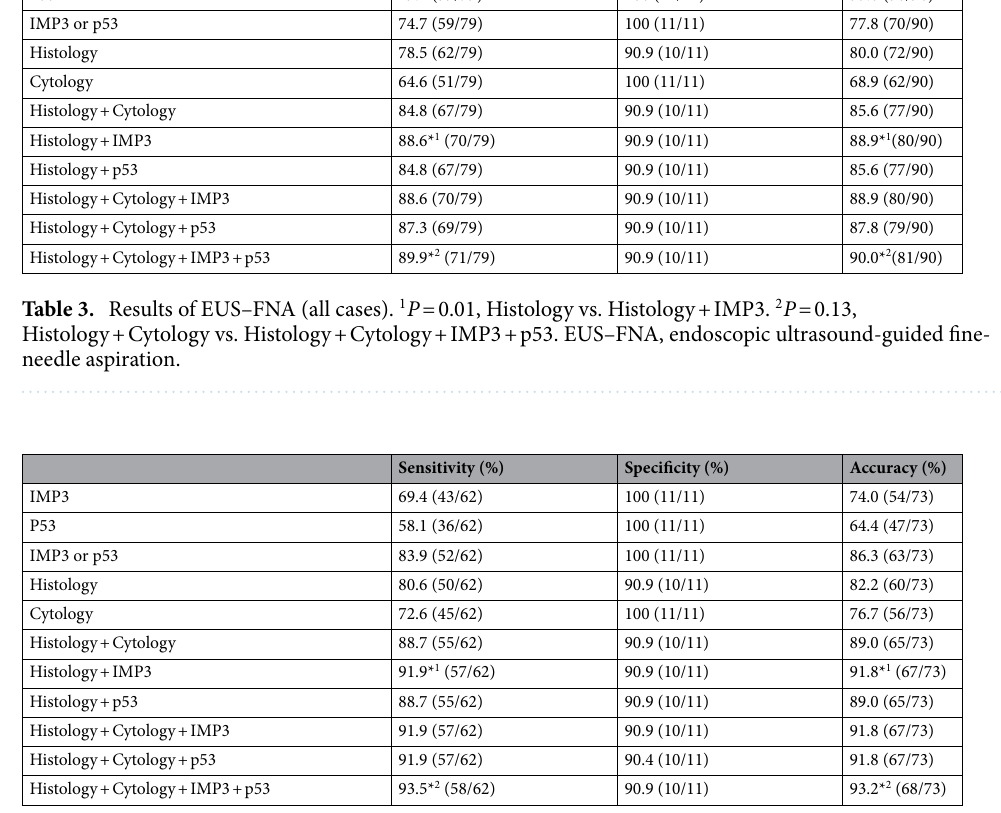
Table 4. Results of EUS–FNA (PDAC and benign diseases). 1 P = 0.02, Histology vs. Histology + IMP3. 2 P = 0.25, Histology + Cytology vs. Histology + Cytology + IMP3 + p53. EUS–FNA, endoscopic ultrasound- guided fine-needle